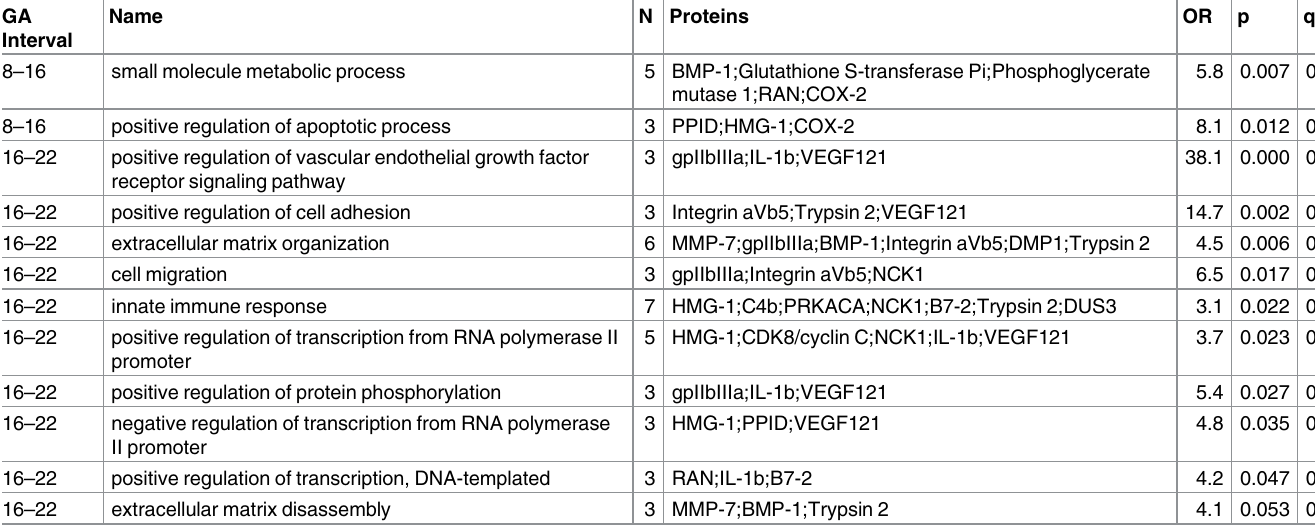
Table 5. Gene ontology (GO) biological processesassociated with protein abundance changes with late-onset